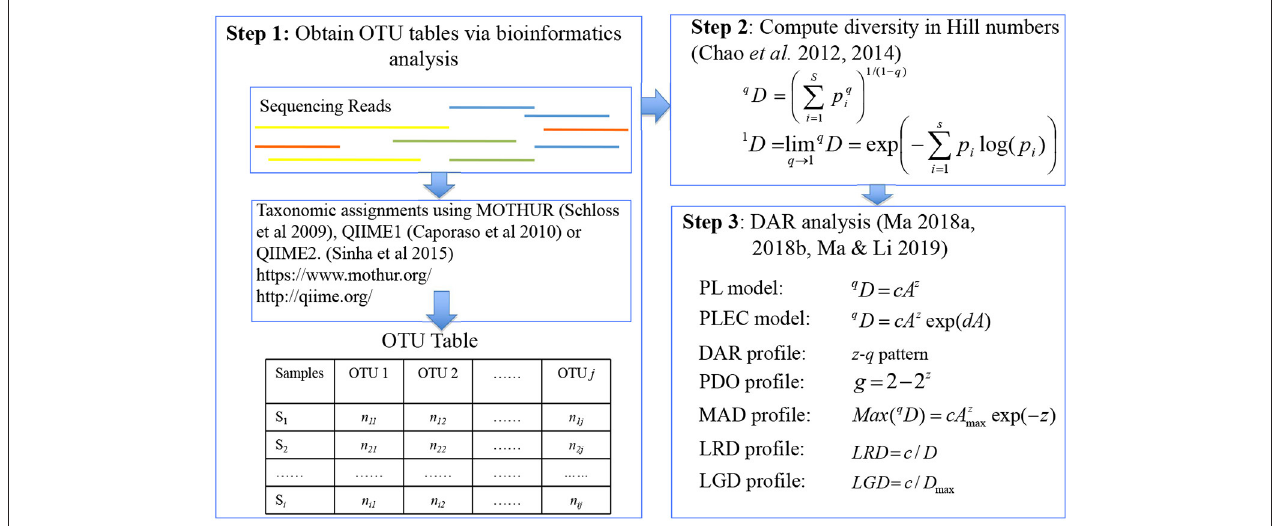
FIGURE 1 | A diagram showing the three steps involved in DAR (diversity-area relationship) analysis: major software packages (MOTHUR, QIIME, QIIME2), data format (OTU table), definitions (Hill numbers), models (PL and PLEC), and concepts (profiles) were illustrated.